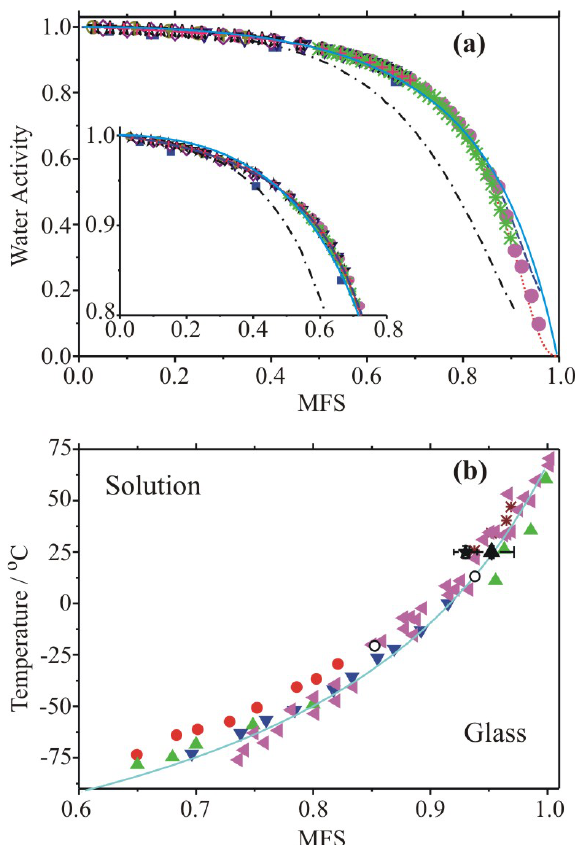
Fig. 2. (a) Water activity as a function of the mass fraction of so- lute (MFS) from the ADDEM model (dotted dashed black line), and the parameterisations of Norrish (1966, dotted red line), Zobrist et al. (2008, light blue line) and Starzak and Peacock (1997, dashed blue line) for the sucrose solution. Experimental data is shown by the symbols: crosses, Scatchard et al. (1938); stars, Robinson and Stokes (1965); squares, Chuang et al. (1976); down triangles, R¨uegg and Blanc (1981); diamonds, Lerici et al. (1983); filled cir- cles, Bressan and Mathlouthi (1994); asterisks, Bubnik et al. (1995); and open circles, Mogenson et al. (2009). The inset shows an ex- panded range above a water activity of 0.8. (b) The glass transition temperature as a function of MFS from previous publications and the present study. For the present study, the composition at the glass transition has been estimated from the water activity and either the Norrish water activity/MFS relationship (black star) or the Starzak and Peacock relationship (black triangle). Literature values: open black circles, Koster 1991; red circles, Ablett et al., 1992; green triangles, Roos 1993; brown asterisks, Blanshard et al., 1991; blue triangles, Franks 1993; purple triangles, Sun et al., 1996; light blue line, Hsu et al.,